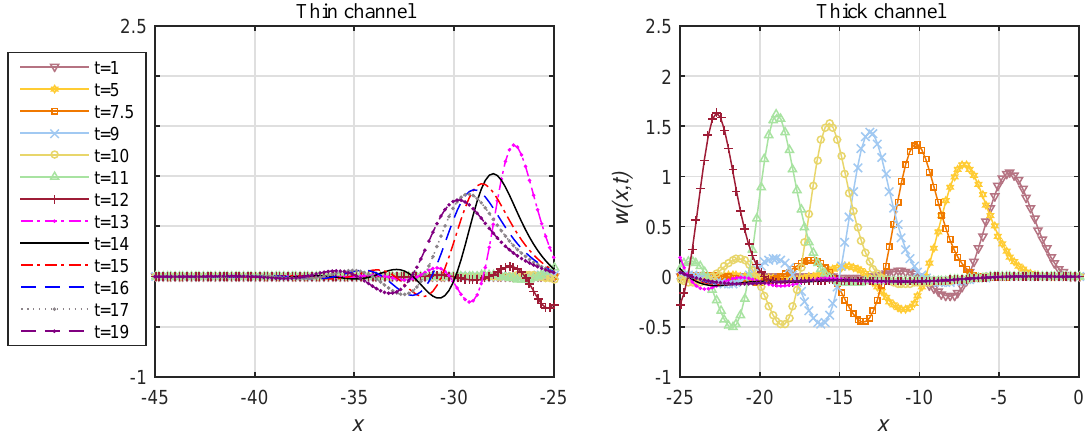
Figure 6. The experiment with α 2 = 2 α 1 ( a = 1/8, b = 1/4, c = 1); the time ranges from t = 1 to 19.